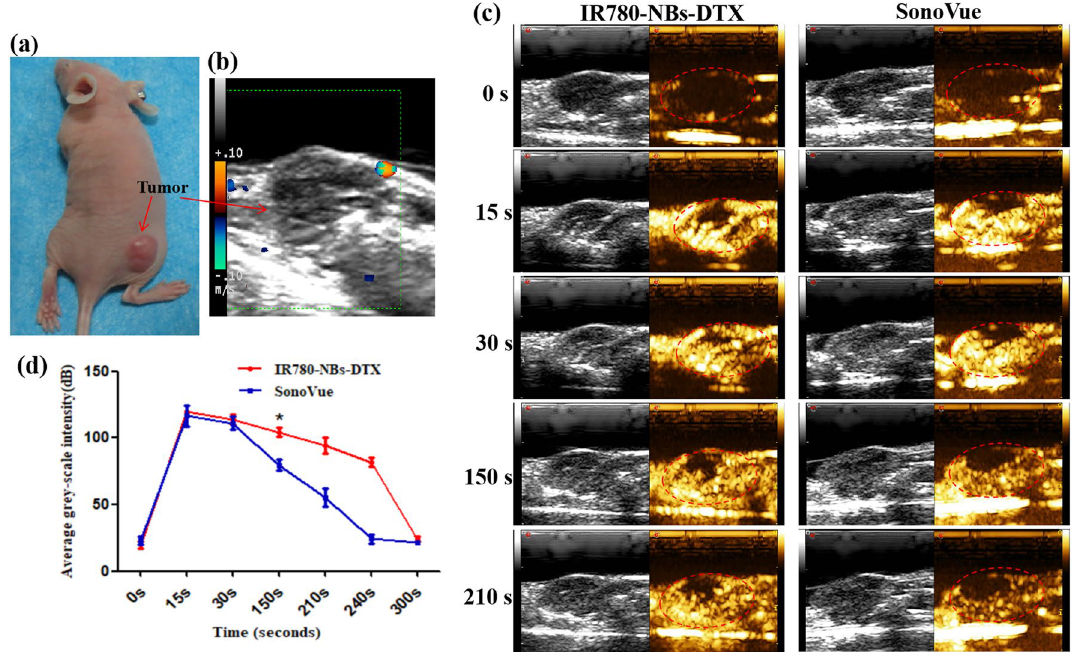
Figure 9. CEUI of IR780-NBs-DTX on subcutaneous xenotransplanted pancreatic cancer in vivo. ( a ) Nude mice bearing subcutaneous xenotransplanted pancreatic cancer. ( b ) Routine ultrasound for pancreatic cancer. ( c ) CEUI of pancreatic cancer mediated by IR780-NBs-DTX and SonoVue. The red dotted lines represent the tumor outline. ( d ) Analysis of the time-dependent echo intensity of CEUI mediated by IR780-NBs-DTX and SonoVue in pancreatic cancer. *P < 0.05, significantly different from the echo intensity of CEUI mediated by SonoVue at 150